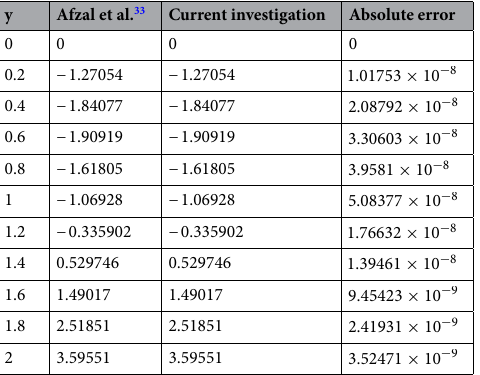
Table 3. Comparison of nanoparticle volume fraction profile solution with x = 1, m 1 = 0.5, α = 0.5, N TC = 0.8, N b = 0.1, N t = 0.8, N CT = 0.8 .